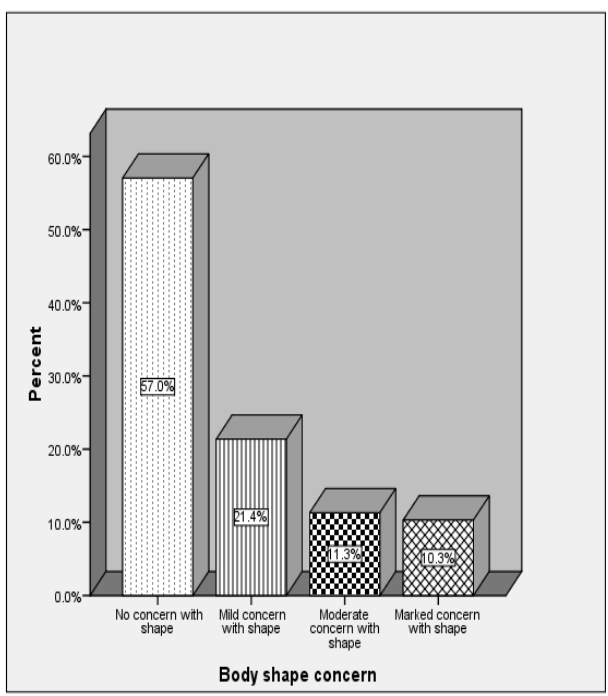
Figure 1: The prevalence of body shape concern measured by Body shape questionnaire (BSQ-34) among the studied group